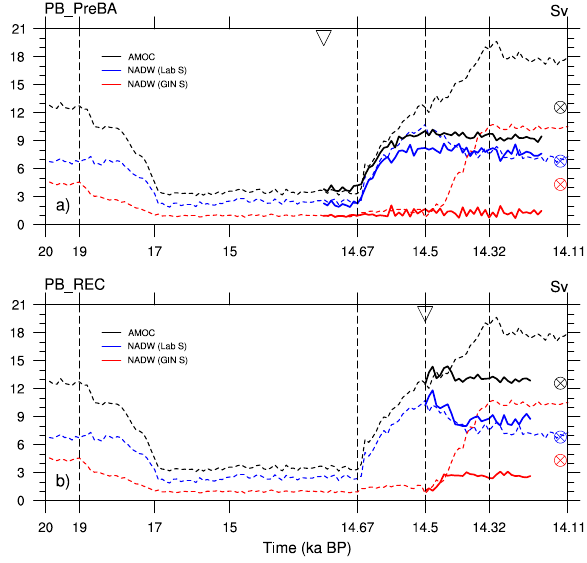
Fig. 2. AMOC strength (black solid line) and regional deep-water formation rate in Labrador Sea (shown as “NADW (Lab S)”, blue solid line) and GIN Sea (shown as “NADW (GIN S)”, red solid line) for PB PreBA (a) and PB REC (b) runs. Dashed lines are the cor- responding series in DGL-A run. AMOC strength is defined as the maximum streamfunction of NA under 500m depth. Deep-water formation rate in the GIN Sea is defined as the vertical maximum value of streamfunction at the south edge of the GIN Sea (62 ◦ N). Deep-water formation rate in Labrador Sea is defined as the differ- ence of AMOC strength and deep-water formation rate in the GIN Sea, assuming AMOC strength defined here represents the total rate of deep-water formation in NA. Inverted triangles and black, blue, and red circles represent the restoring time of each sensitivity exper- iments, the LGM level of AMOC strength, and regional deep-water formation rate in the Labrador and GIN Sea, respectively. All series are based on the decadal mean data, and apply the 3-point running